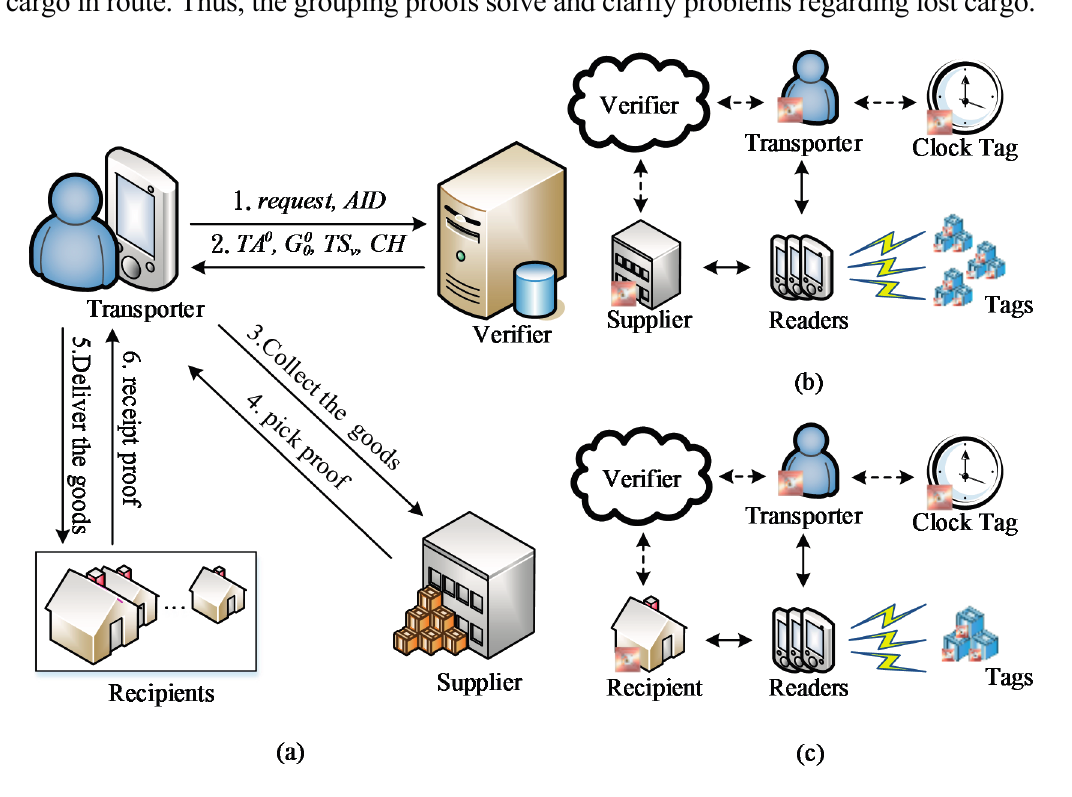
Figure 1. Process of supply chain distribution and grouping proof: ( a ) steps of the supply chain distribution; ( b ) generate the grouping proofs for pick up and delivery; ( c ) generate the grouping proofs for cargo